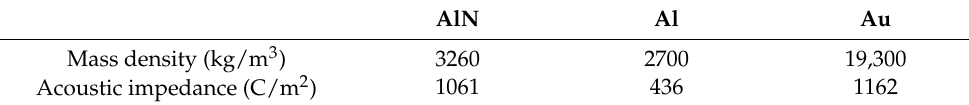
Figure 8. Admittance diagrams of LWRs using Au as the top electrode material with the IDT electrode period of: ( a ) 12 µ m and ( b ) 2 µ m. Table 3. Mass densities and acoustic impedances of AlN, Al, and Au.